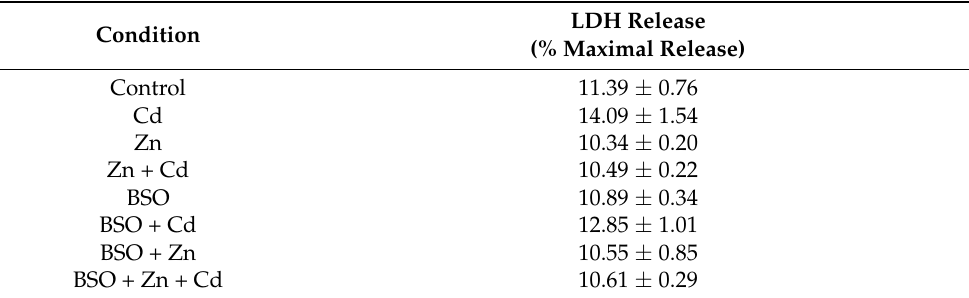
Table 6. Lactate dehydrogenase (LDH) release in choroid plexus epithelial cells exposed for 12 h to 500 nM CdCl 2 with Zinc supplementation and inhibition of glutathione synthesis by L -buthionine sulfoximine